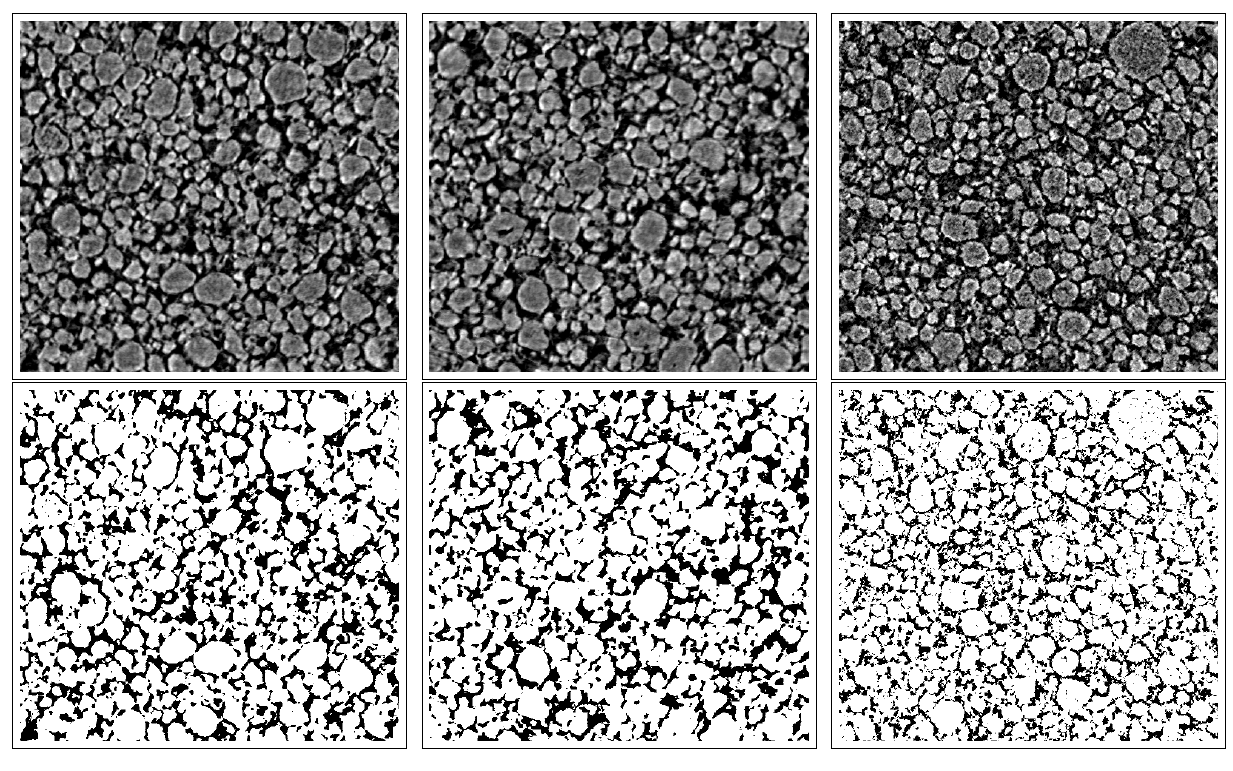
Figure 9. 2D slices from the reconstructed grayscale (first row) and the binary (second row) images of P 1 ( left ), P 2 ( center ) and D 1 ( right C E C